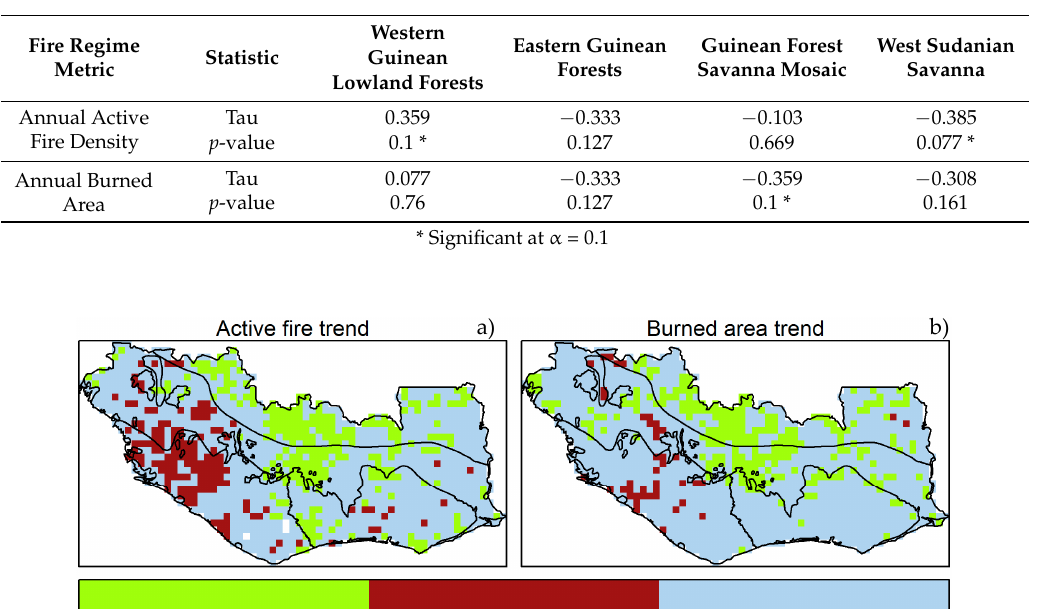
Figure 6. Time series of: ( a ) annual MODIS active fire density; ( b ) total burned area across ecoregions and the entire study area for the period 2003–2015. Table 3. Nonparametric Mann–Kendall tests to detect trends in fire activity at ecoregion scale from 2003–2015. Positive Kandall’s tau statistic values indicate increasing trends, whilst negative values indicate decreasing trends.